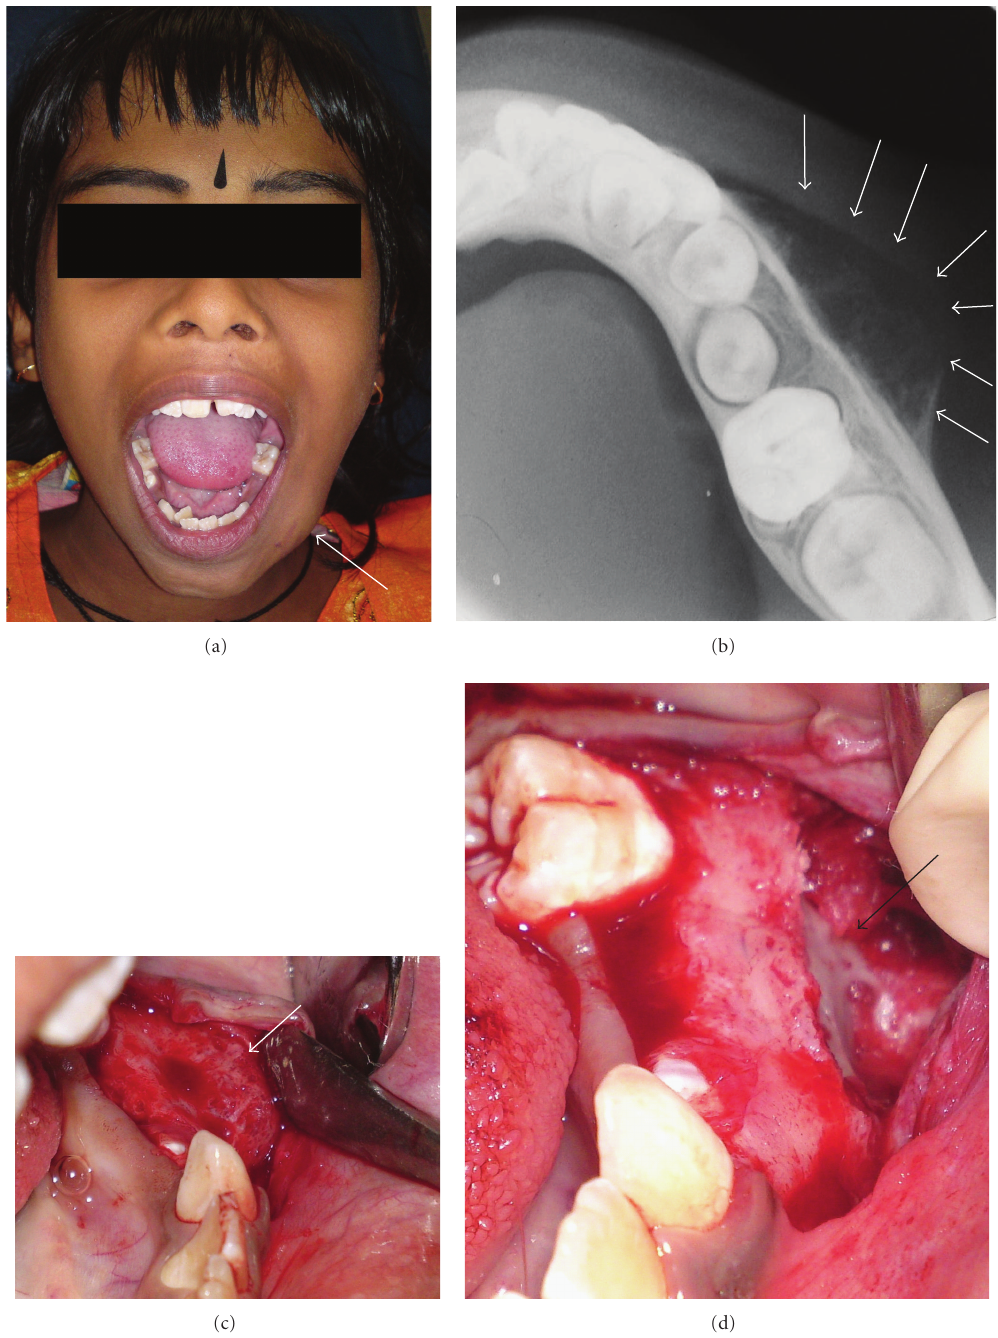
Figure 4: (a) Swelling of the mandible of 2-month duration. (b) Mandibular occlusal radiograph showing intact cortical plate and periosteal bone formation (arrows). (c) On surgical exposure, bony lesion seen. (d) Bone removed for